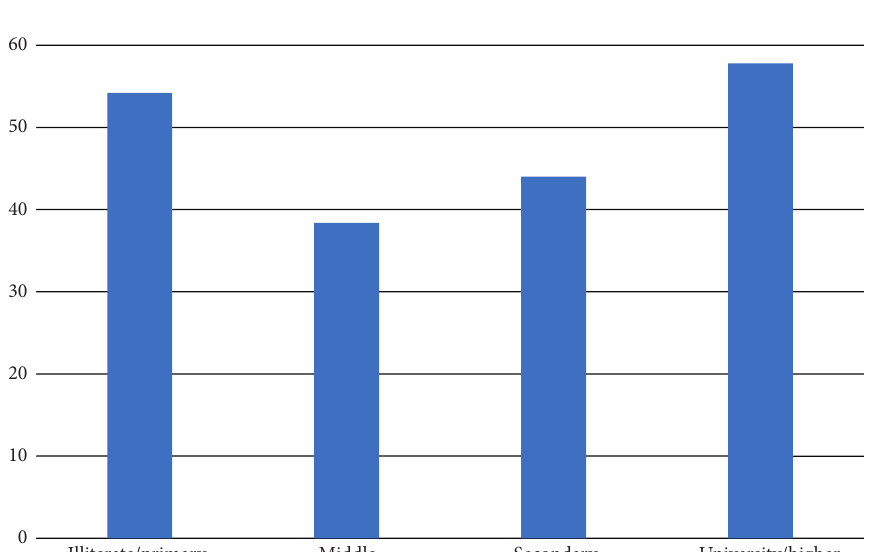
Figure 2: Prevalence of exclusive breastfeeding practice among mothers at education